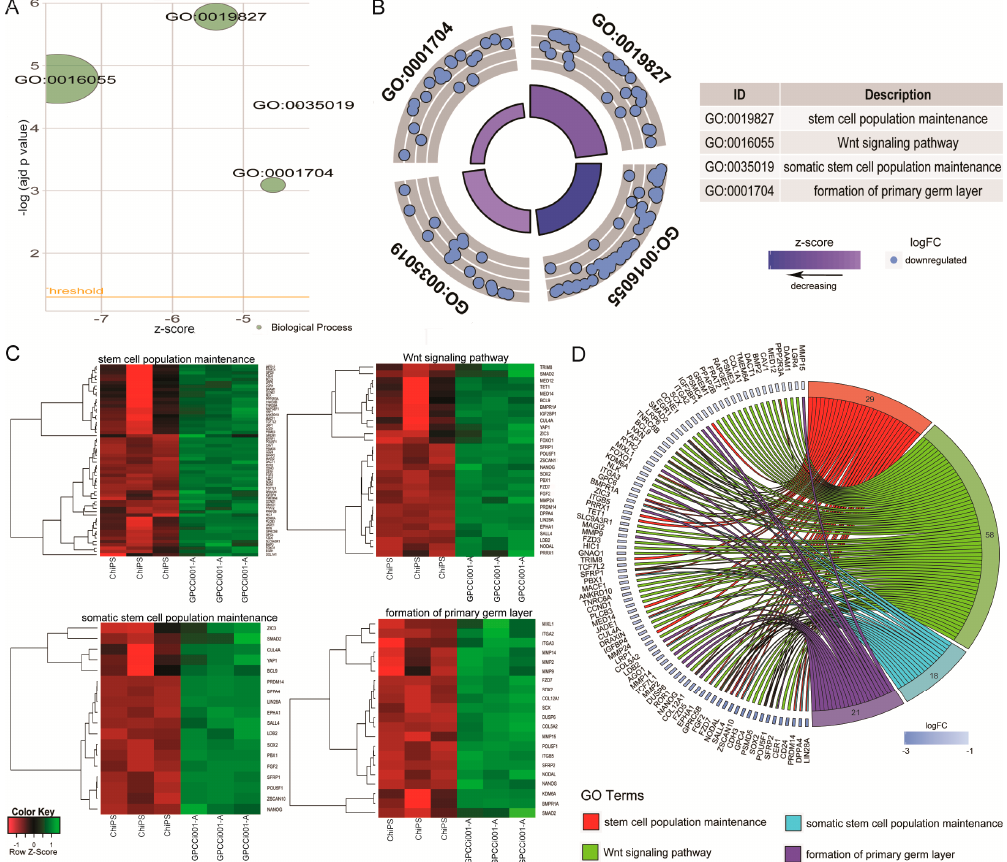
Figure 4. Bubble plot of four significantly-enriched Gene Ontology (GO) terms related to pluripotency regulation and differentiation, which were: “stem cell population maintenance”, “Wnt signalling pathway”, “somatic stem cell population maintenance”, and “formation of primary germ layer”. The negative logarithm of the adjusted p -value from all analyzed GO terms is given on the y -axis, while the Z -score value is shown on the x -axis ( A ). The circular scatter plot shows the differentially expressed genes assigned to each GO term. The logarithm of the fold change value (logFC) of differentially expressed genes is shown ( B ). Heat map graphs of genes from the following GO terms: “somatic stem cell population maintenance”, “stem cell population maintenance”, “formation of primary germ layer”, “Wnt signalling pathway”. Arbitrary signal intensity acquired from the microarray analysis is represented by the colours (green—higher; red—lower expression). Log2 signal intensity values for any single gene were resized to Row Z -Score scale. Genes belonging to the relevant GO term are described by their symbols ( C ). Circos plot demonstrating relationship between selected GO terms and their genes. Genes are located on the left side of the graph and indicated by their symbols. Genes were ordered based on their logFC values. Gene involvement in the GO terms was determined by connecting lines ( D ). The logarithm of the fold change (logFC) of differentially expressed genes assigned to each GO term is shown in Figure 4B, where each blue circle displays the down-regulated genes assigned to